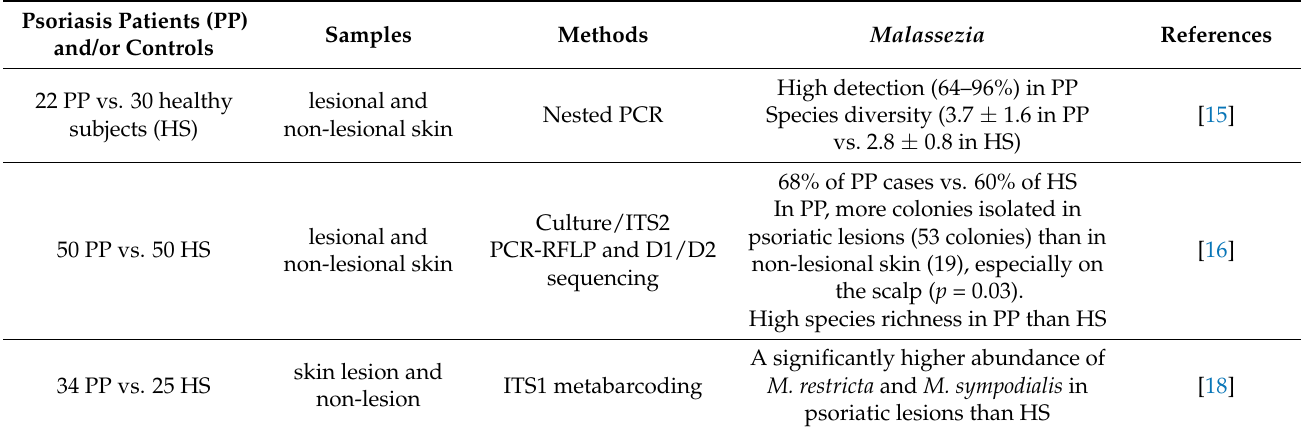
Table 1. Studies showing the association of Malassezia with